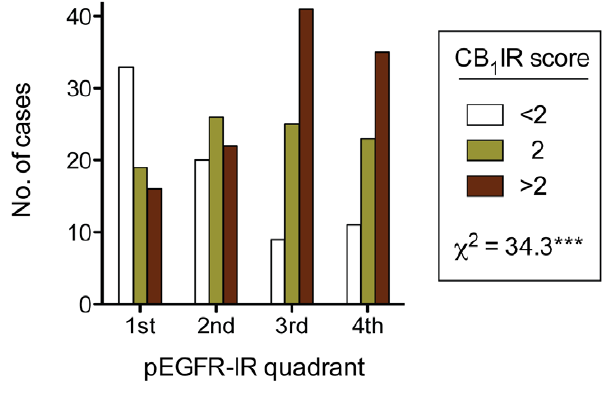
Figure 1. Distribution of CB 1 IR scores for different pEGFR scores in prostate tumour tissue. The pEGFR scores were divided into quadrants (1st, pEGFR , 2.6, n=68; 2nd, 2.6–3.29, n=68; 3rd 3.3– 3.7, n=75; 4th, . 3.7, n=69) and the CB 1 IR score at each quadrant shown. The number of cases with CB 1 IR scores , 2, 2 [the median value] and . 2 were 73, 93 and 114, respectively. ***p , 0.001, x 2